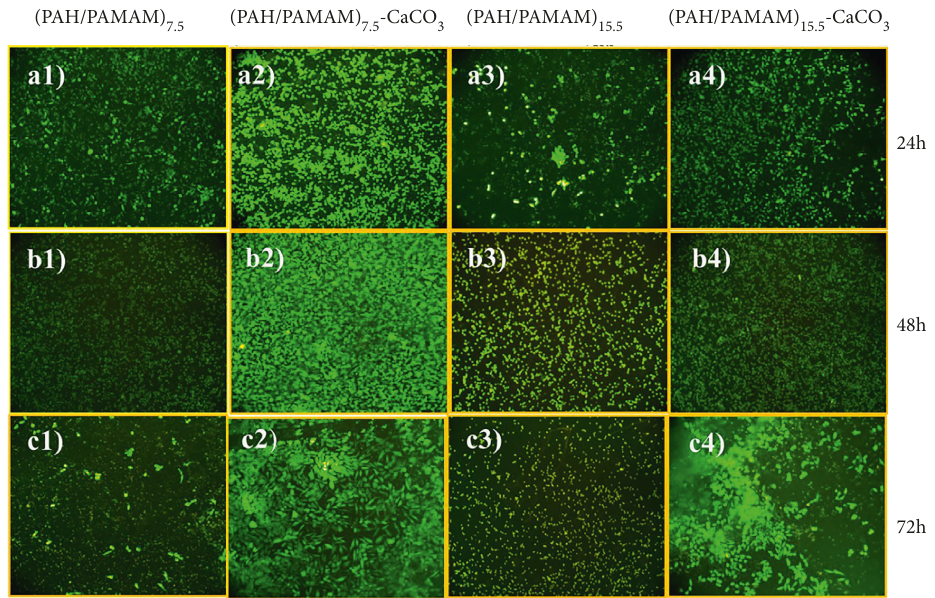
Figure 11: Fluorescent images of HLFCs cultured (a1–a4) 24 h, (b1–b4) 48h, and (c1–c4) 72 h on substrates with different bilayers. Control experiment, no CaCO 3